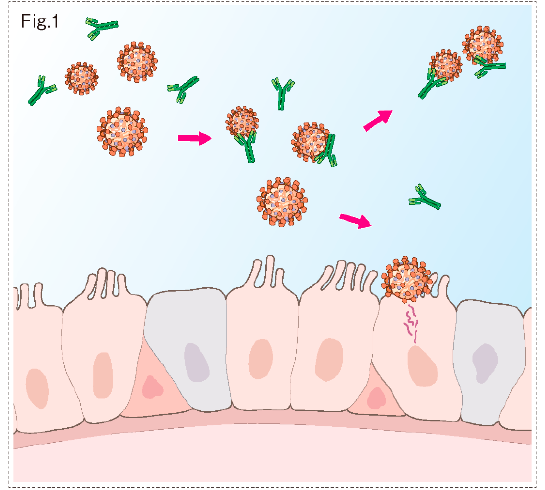
Figure 1. SIgA in saliva prevents the invasion of pathogens such as bacteria and viruses by which SIgA inhibits pathogen attachment and settlement to the mucous membrane by binding and aggregating pathogens.